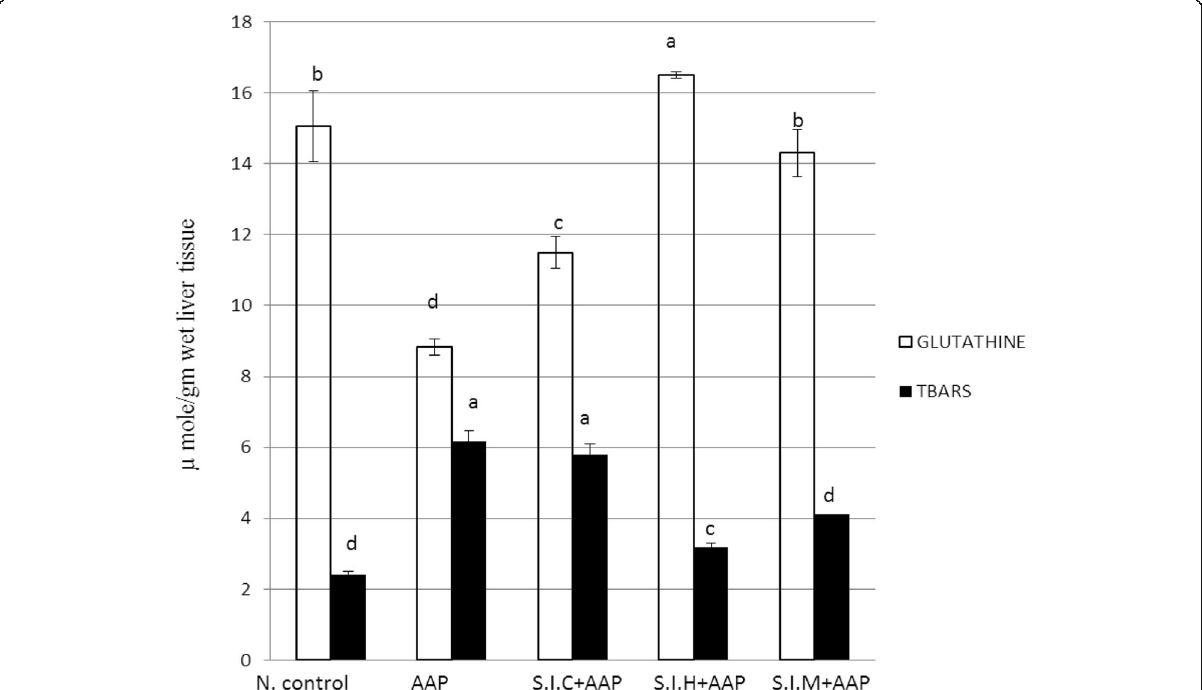
Fig. 1 Effect of chloroform, n -hexane and methanol soluble fractions of Sargassum ilicifolium on glutathione (GSH) and lipid peroxidation (TBARS) in acetaminophen (AAP) dosed rats. The bars in the graph showing mean ± Standard error. The values having the same superscript on the bars are not significantly ( p < 0.05) different according to Duncan ’ s multiple range test